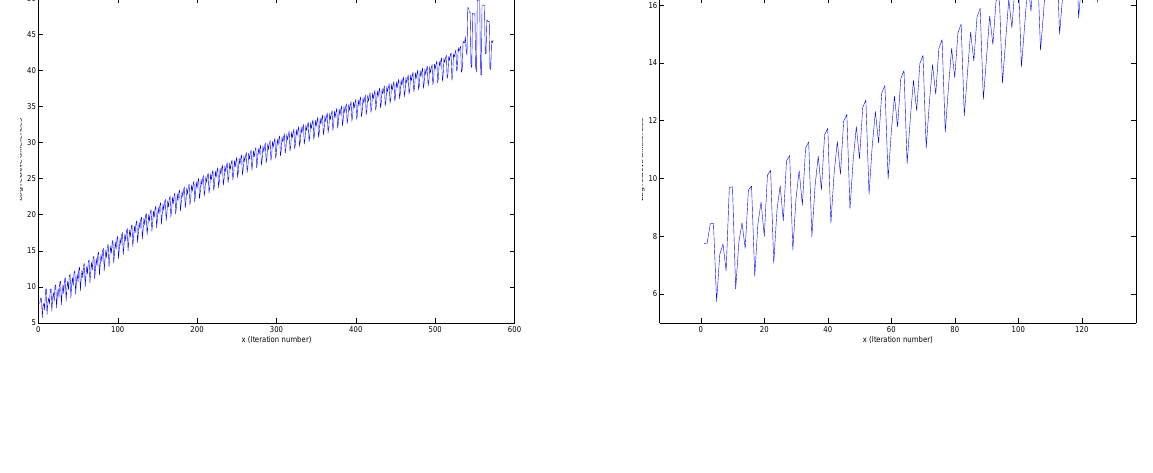
Figure 7. Two further examples of simultaneous normalization: these illustrate that simultaneous normalization does not lead to